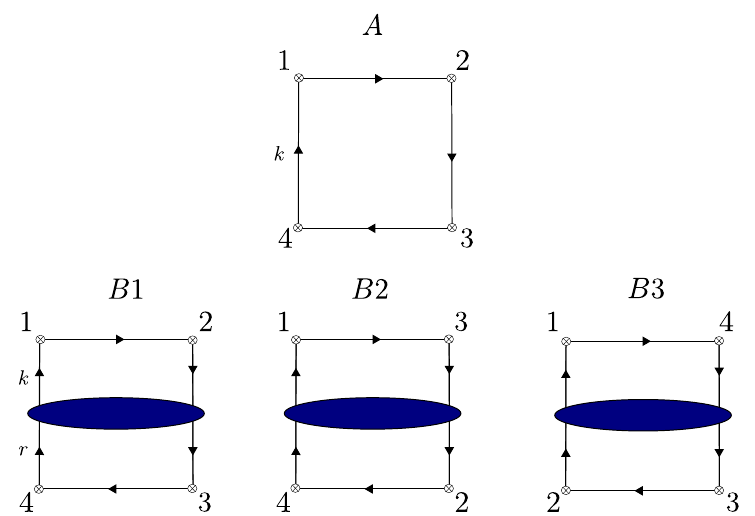
Figure 2 . Diagrams contributing to the four-point function of O qf ( q ). The momenta of the external particles q is along direction 3 and always incoming. Diagrams B include the four-fermion vertex which is denoted by a blue blob. We omit the other 5 permutations of diagram A and show only nonequivalent configurations of diagram